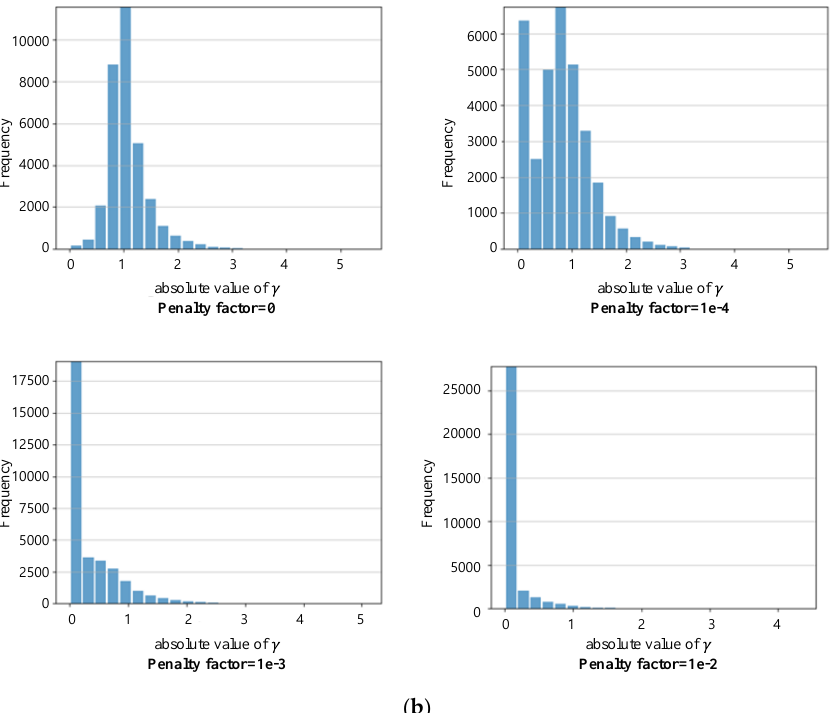
Figure 14. Histogram of γ according to the penalty factor α. ( a ) Visdrone2019-Det; ( b ) SCOD. Table 4. Detection performance of networks according to penalty coefficient α.